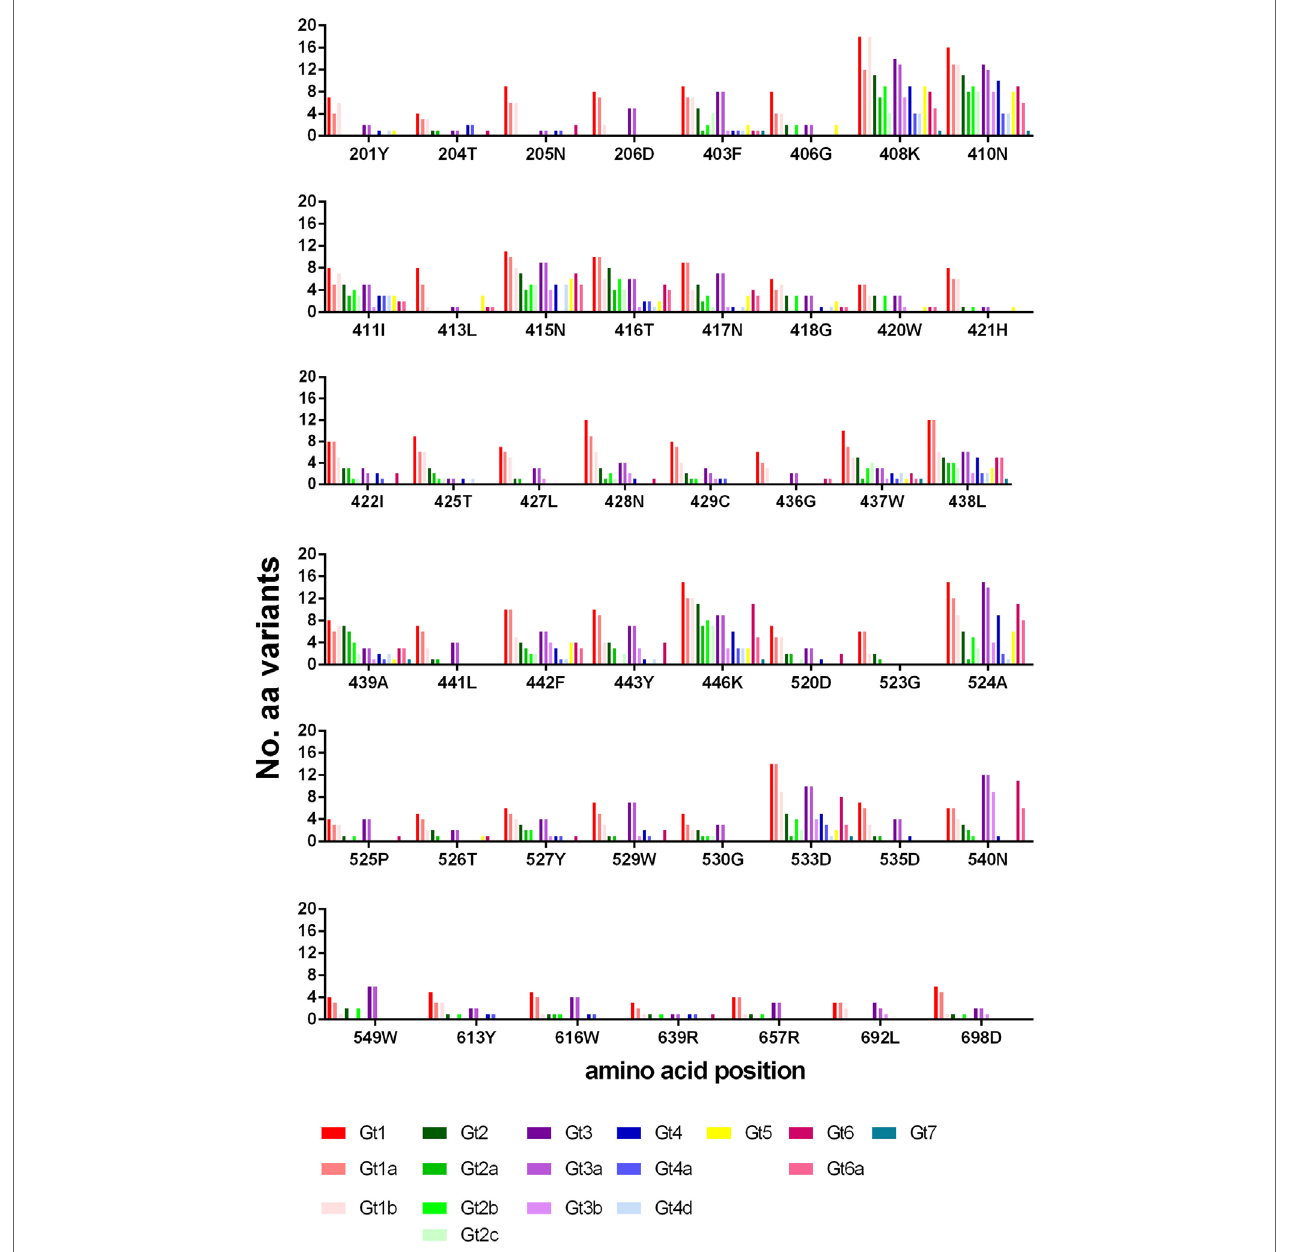
FigUre 4 | Variance of bNAb bound residues. The number of different amino-acid variants for each residue is shown across the different genotypes and subtypes. Gt1 (red), Gt2 (green), Gt3 (purple), Gt4 (blue), Gt5 (yellow), Gt6 (pink) and Gt7